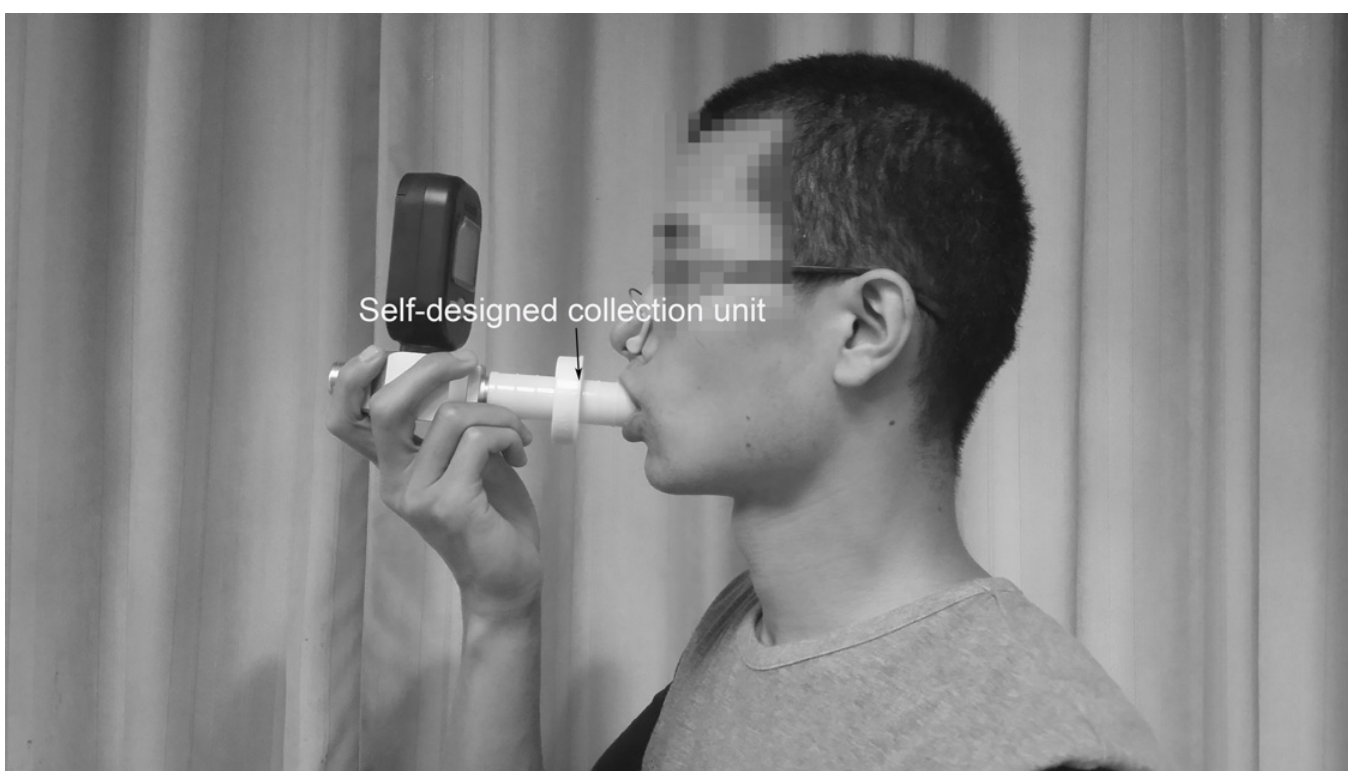
Fig 3. Collecting exhaled breath particles using a self-designed collecting